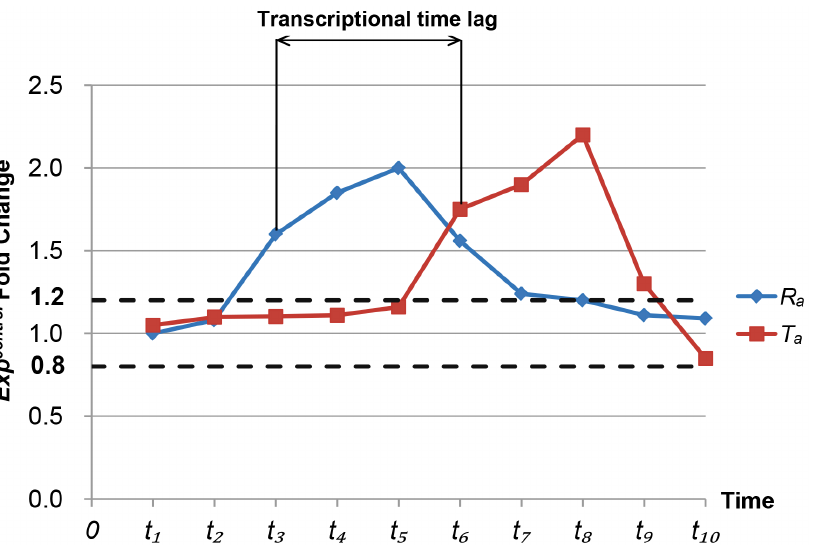
Figure 2. Estimation of transcriptional time lag. The figure shows the estimation of transcriptional time lag. In this example, with respect to the R a - T a gene pair, the time points of the initial changes in their expression of the control group are t 3 and t 6 , respectively. Thus, the transcriptional time lag is t 6 { t 3 ~ 3 time unit